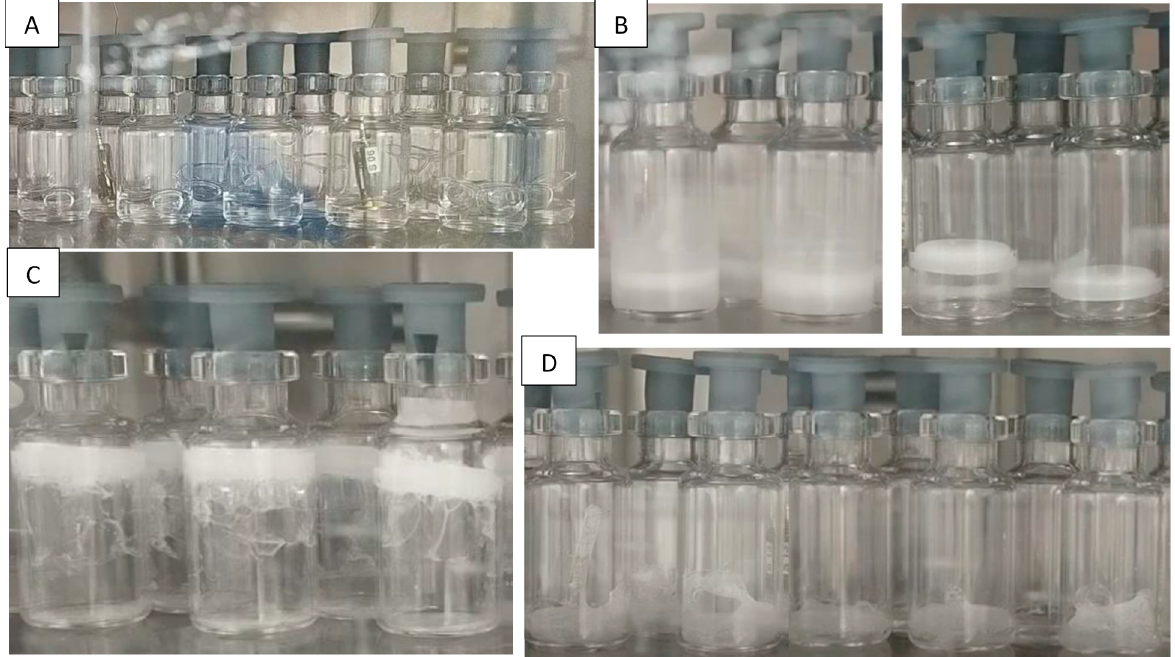
Figure 1. ( A ) Bubbling observed in untreated vials filled with 5% w / w mannitol + 0.02% w / v Tween 80 (the chamber pressure was 6 mbar). ( B ) Fogging observed in sulfate-treated vials ( left ), but not in TopLyo vials ( right ) filled with 5% w / w mannitol, immediately after nucleation. ( C ) Blow up observed in TopLyo vials filled with 5% w / w sucrose + 0.02% w / v Tween 80. ( D ) Irregular product in TopLyo vials filled with demineralized water, caused by boiling. All these pictures were taken immediately after nucleation.